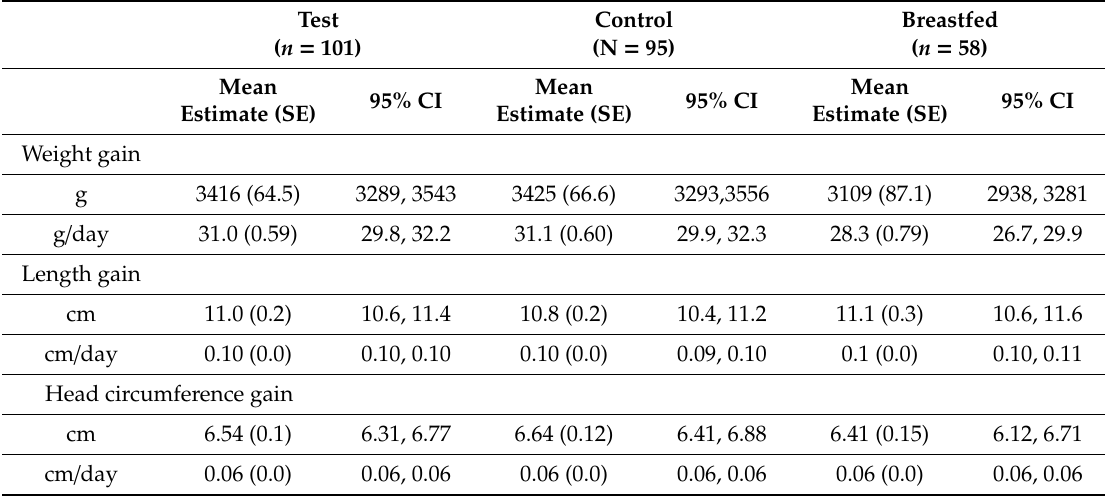
1 Per protocol population and Breastfed reference. 2 Data were modelled with a Parametric Growth Curve (PGC) mixed model with a quadratic function of time. The stratification factors of sex, site, and birth weight as covariate were added to the model. For the analyses including the Breastfed reference group, maternal BMI was included as an additional covariate for weight and length gain, and maternal education was also included as a covariate